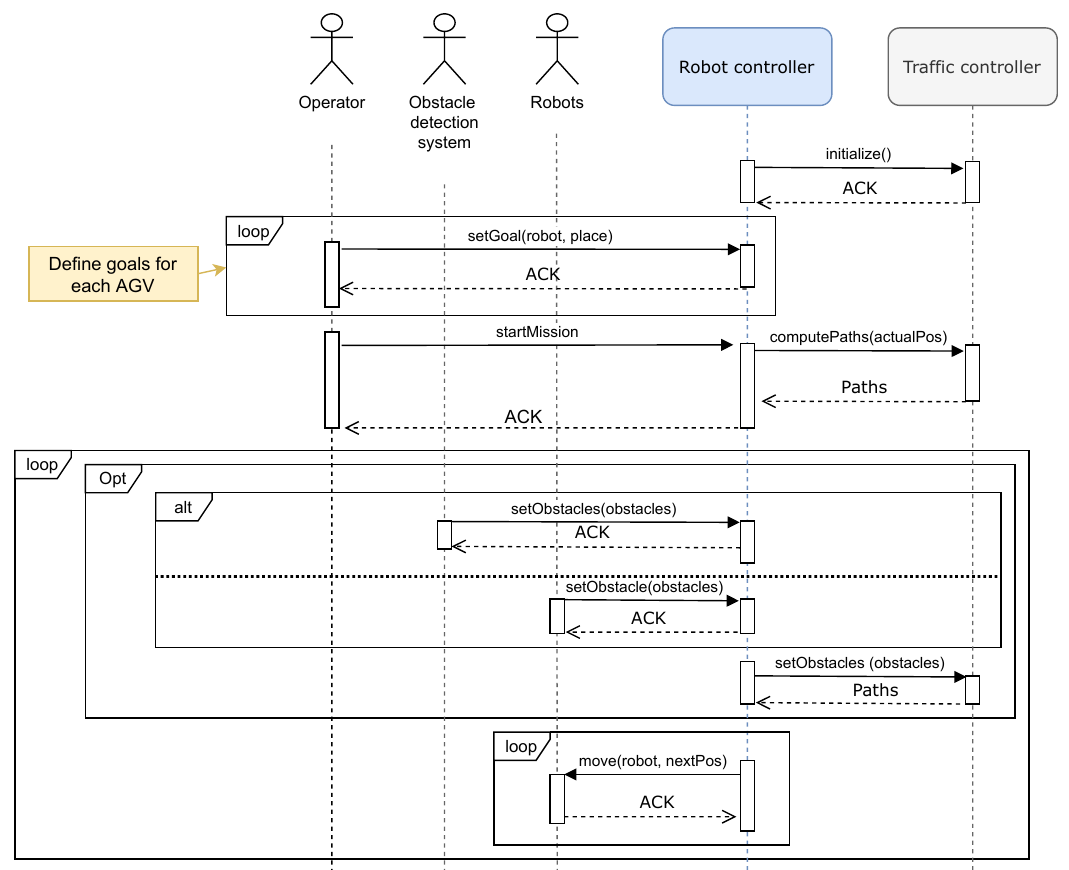
Figure 2. AGV navigation sequence